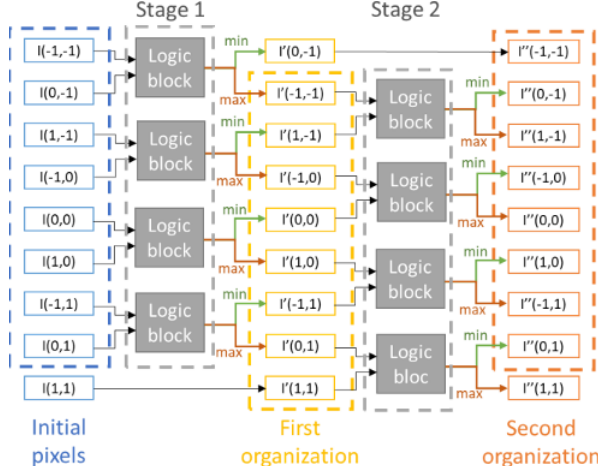
Fig. 8. Median filter design